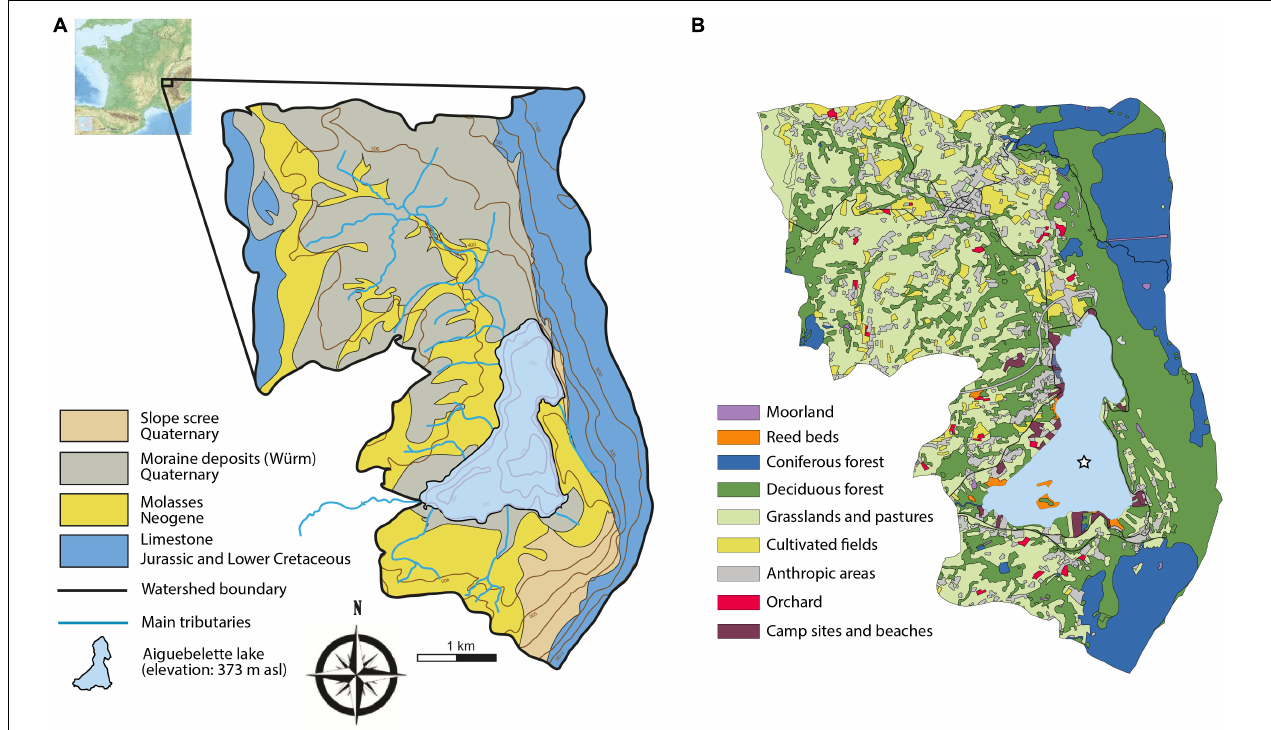
FIGURE 1 | (A) Location, geology and (B) land cover of the Lake Aiguebelette catchment.